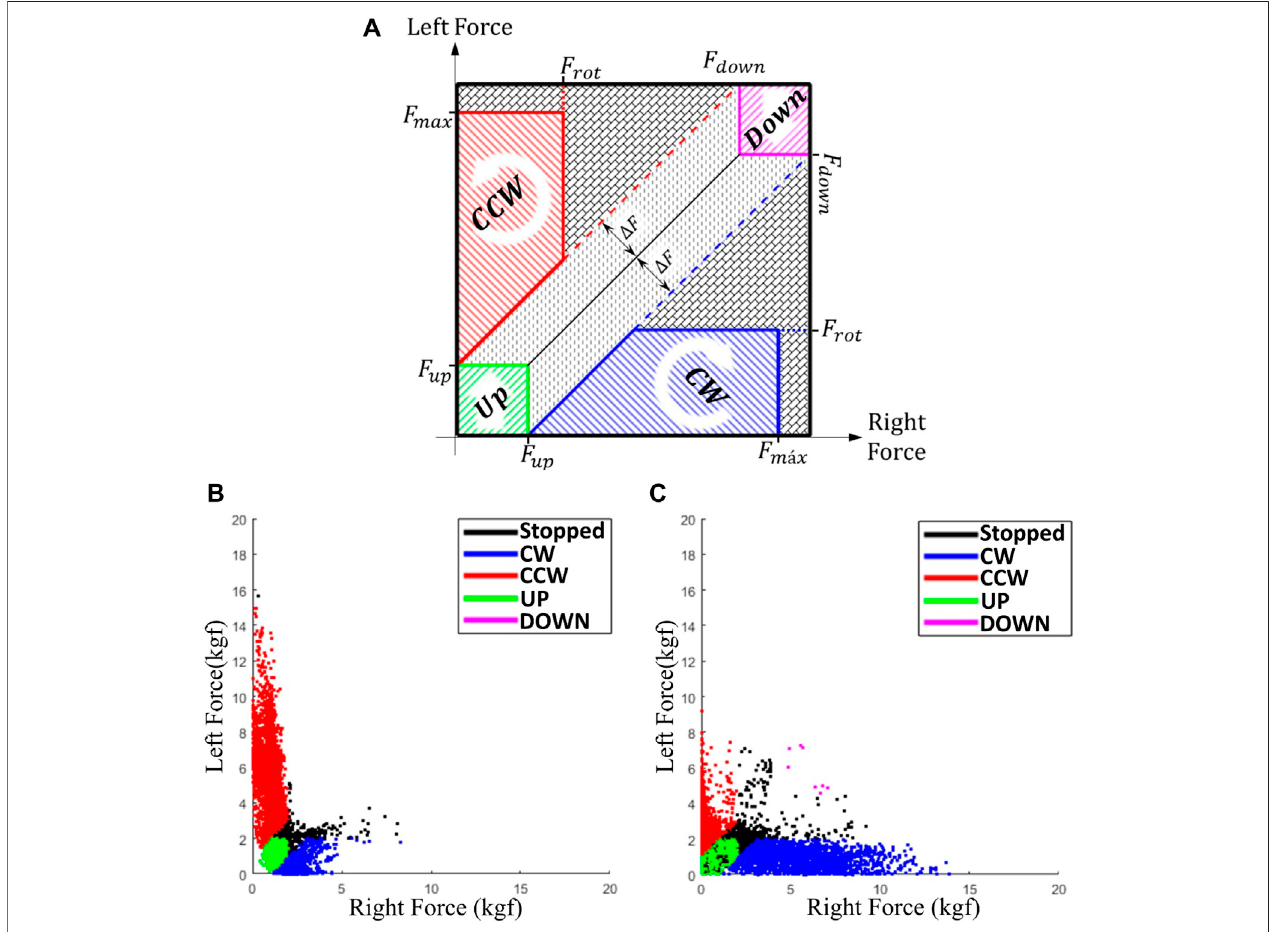
FIGURE 7 | Force map graph for the bimanual serious games, (A) constraints and effects for rotation and translation movements, (B) activation distribution example of a right and (C) left hemiparetic subject.